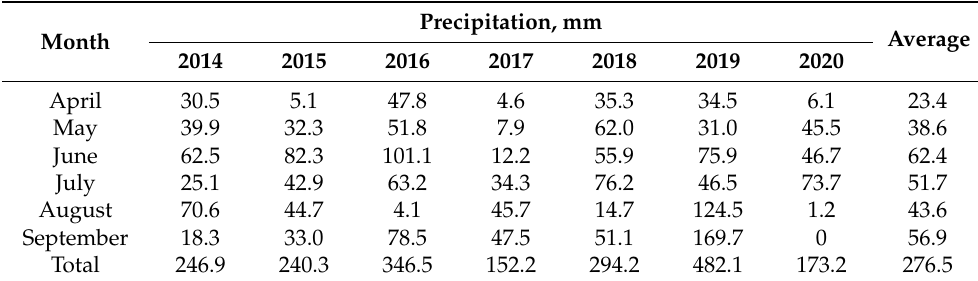
Table 1. Monthly precipitation from April to September during 2014–2020 growing seasons at the research site near Culbertson, MT, USA.